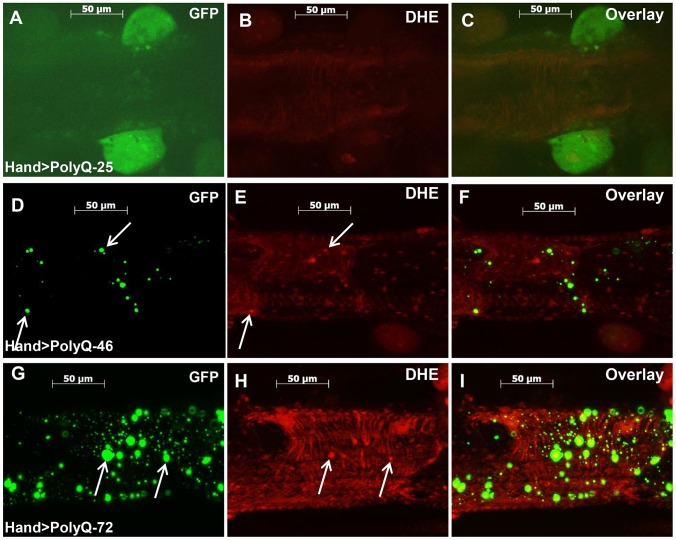
Mutant PolyQ induces oxidative stress.(A–C) Immunofluorescence micrographs showing GFP expression and DHE staining in hearts expressing PolyQ-25. (D–F) GFP expression and DHE staining in hearts expressing PolyQ-46 and (G–I) GFP expression and DHE staining in hearts expressing PolyQ-72. Expression of mutant PolyQ correlates with enhanced DHE staining and more aggregation compared to age-matched control (PolyQ-25), with moderate length PolyQ (PolyQ-46) expressing hearts showing less staining than PolyQ-72 hearts. Note that many of the GFP-positive aggregates co-localize with areas of strong DHE staining in the merged images for both PolyQ-46 and 72 (arrows).